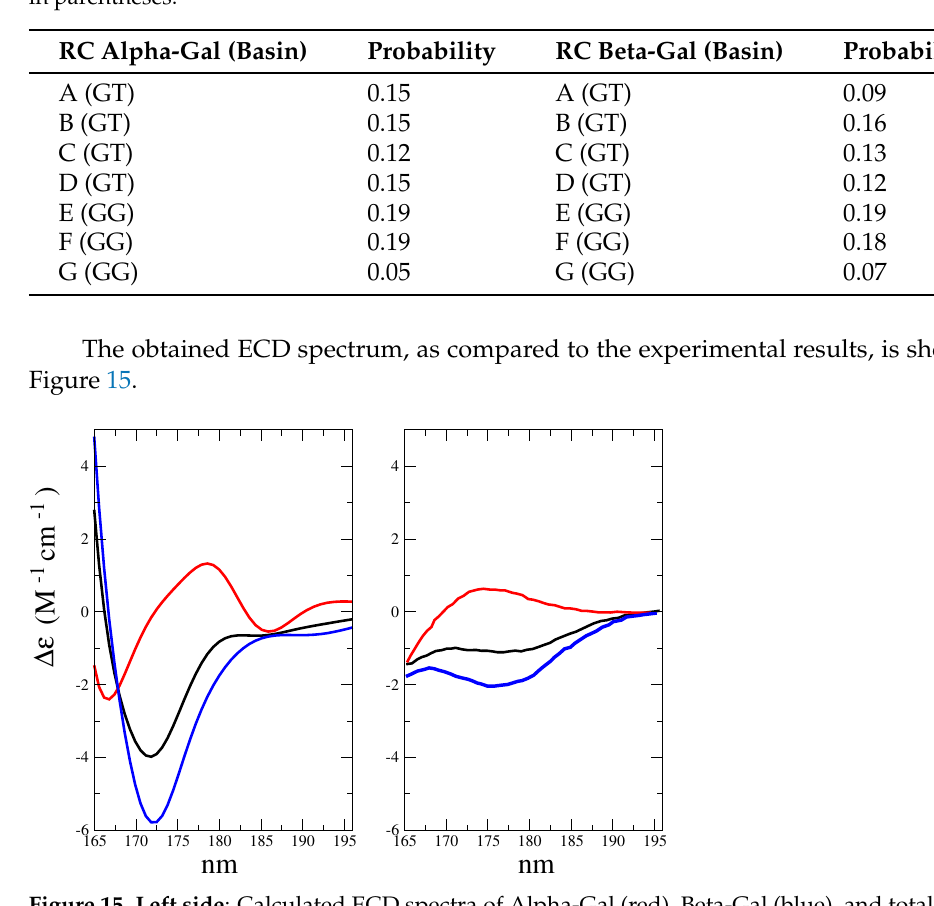
Figure 15. Left side : Calculated ECD spectra of Alpha-Gal (red), Beta-Gal (blue), and total (black), in a water solution. Right side : Reproduction of the experimental spectra from reference [35] of Alpha-Gal (red), Beta-Gal (blue), and total (black), in a water